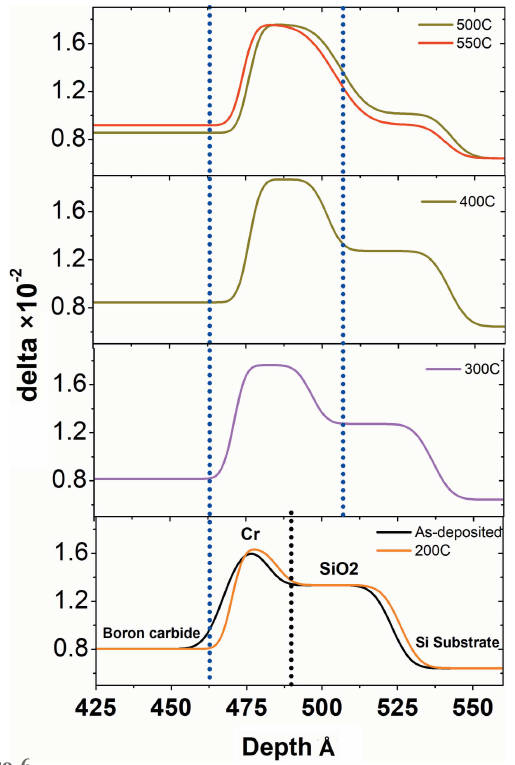
Figure 6 The optical density profile of the Cr–SiO 2 region is plotted for each annealing